Question: Is the quantity shown trending increasing or decreasing?
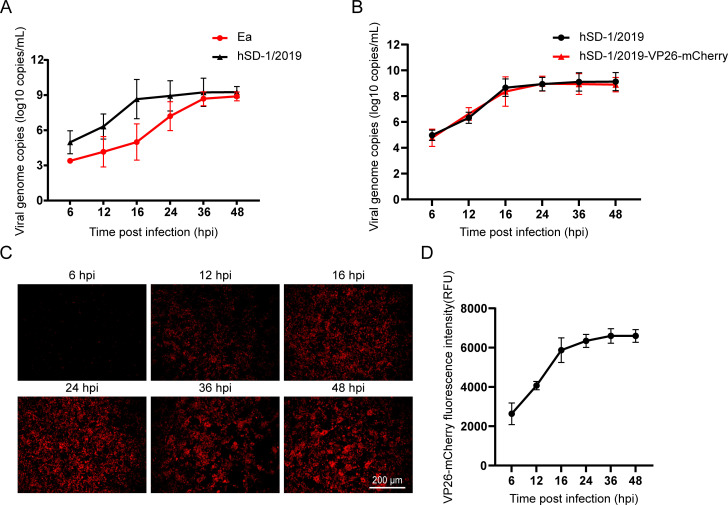
Answer: increasing